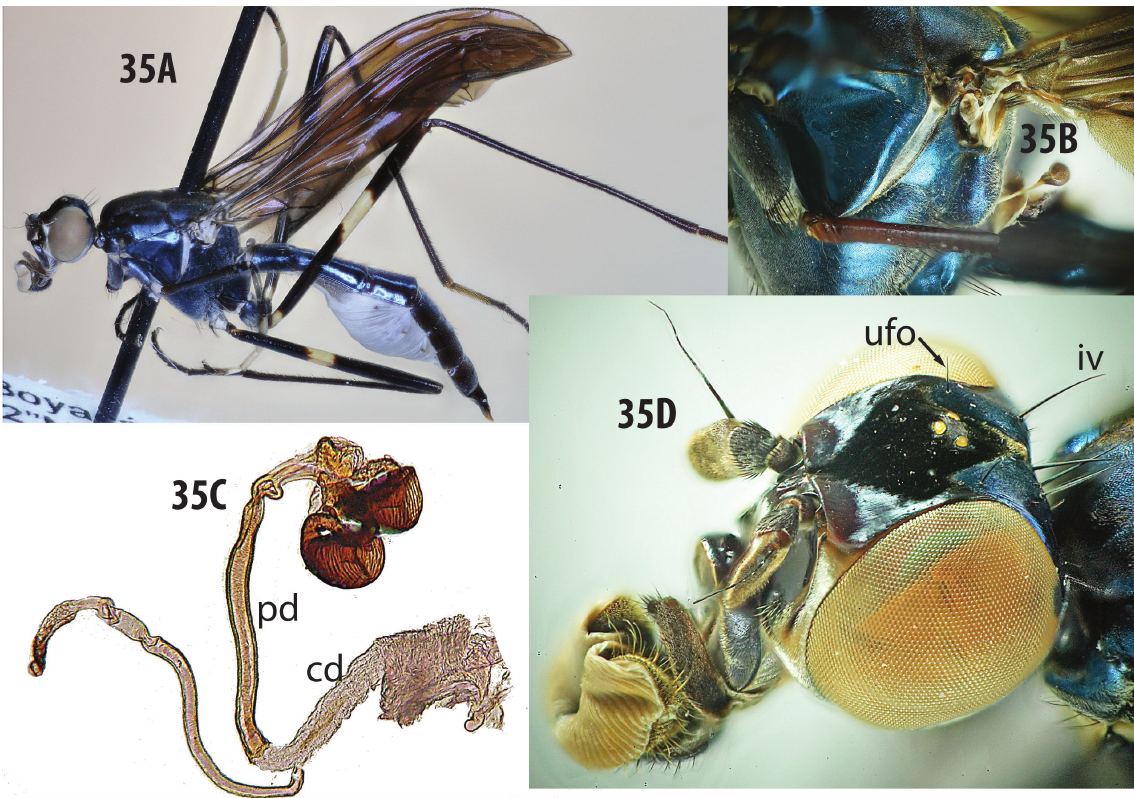
Fig. 35. Mesoconius reinai sp. nov., holotype, ♀, IAVH. A . Lateral view. B . Pleuron, showing slightly swollen katatergite. C . Spermathecae and associated structures. D . Head. Abbreviations: cd = common spermathecal duct; iv = inner vertical bristle; pd = paired spermathecal duct; ufo = upper